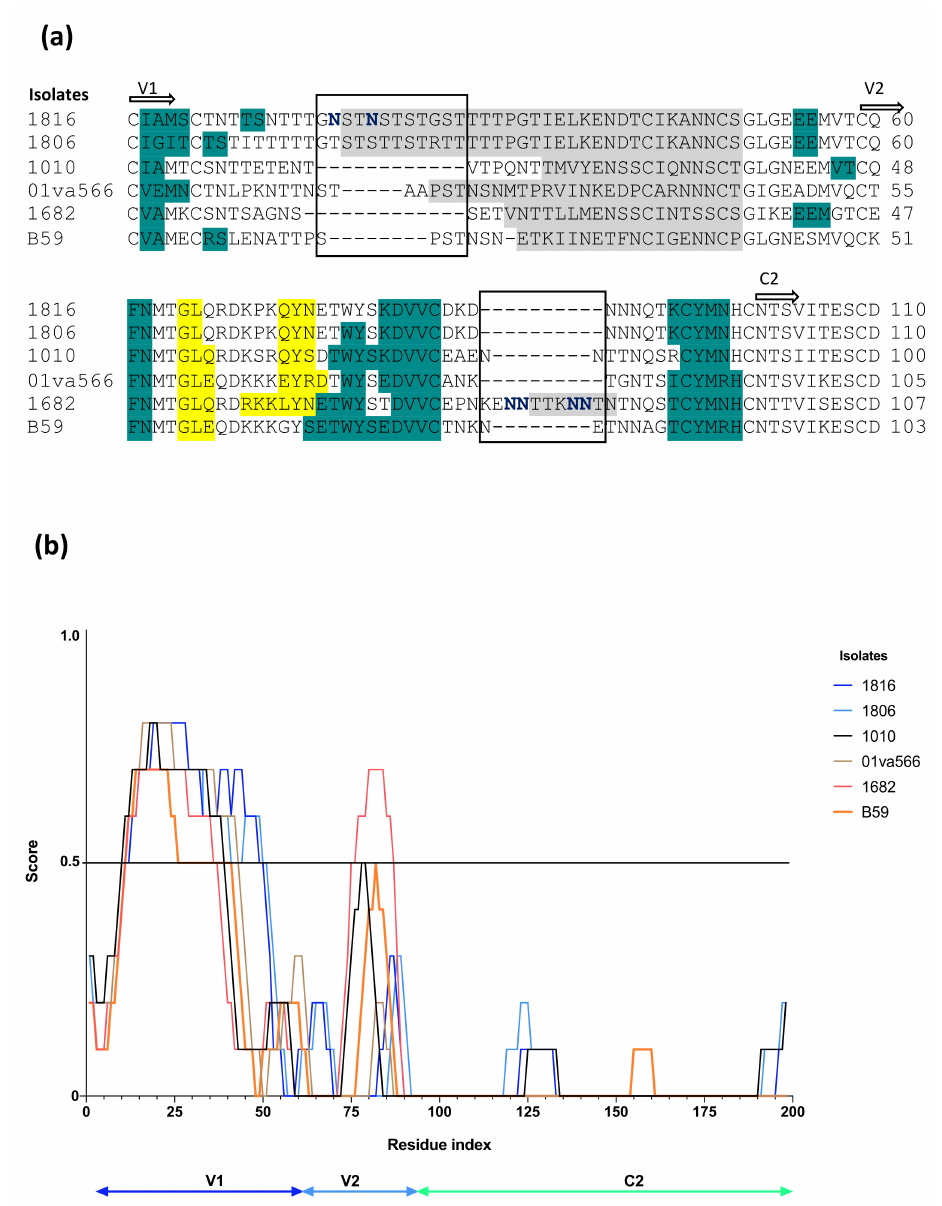
Figure 3. Characterization of the Env V1/V2 regions of HIV-2 isolates with CCR5 and GPR15 use. ( a ) Secondary structure prediction of V1/V2 regions of HIV-2. Teal dark green represents beta strand, yellow represents alpha-helix, while the grey represents the predicted disordered regions. Black boxes indicate regions with insertions. Potential N-linked glycosylation sites within the insertions are represented in dark blue. ( b ) Disorder prediction of the V1/V2 and C2 regions of HIV-2 Env. Prediction was performed using IUPred3 and SPOT-Disorder2 online servers [31,32]. Cut-off is represented with line at score